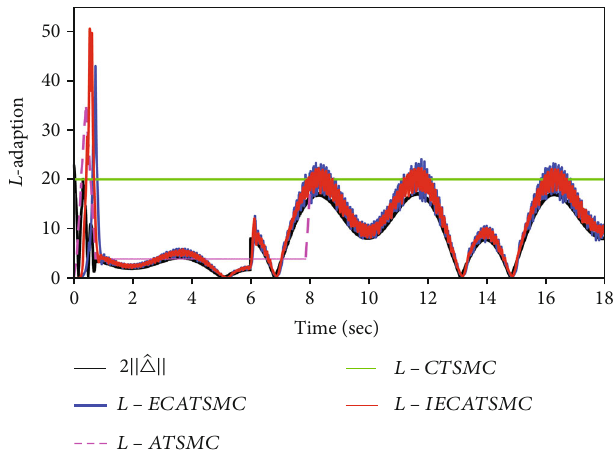
Figure 4: Adaptive gain curves.